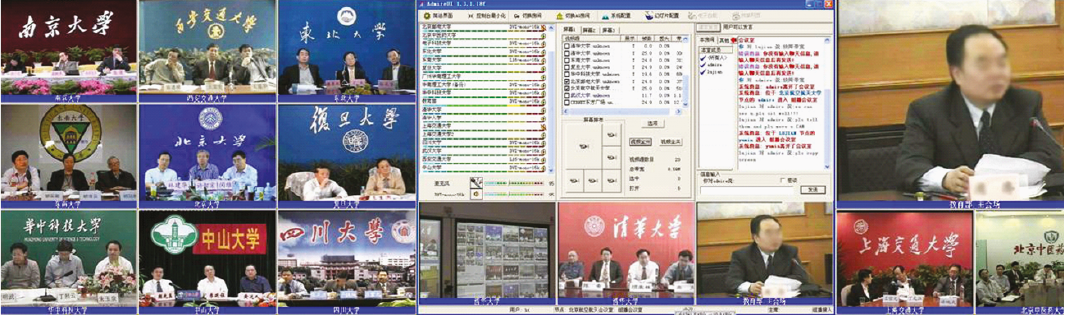
Figure 1: A practical video conference in Admire